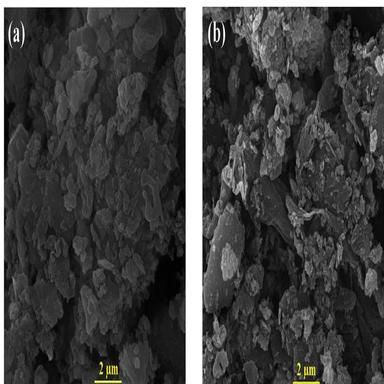
SEM images of (a) as-received ABD, and (b) acid-insoluble residue after leaching.